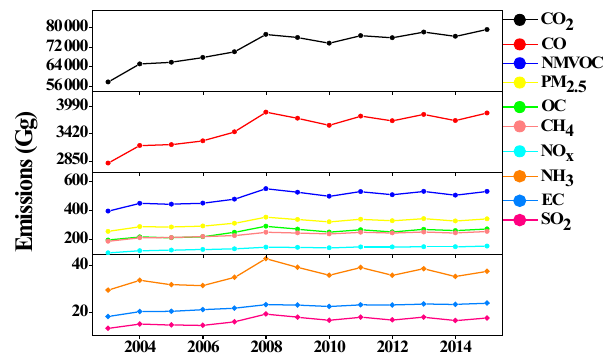
Figure 5. Yearly emissions of open biomass burning from 2003 to